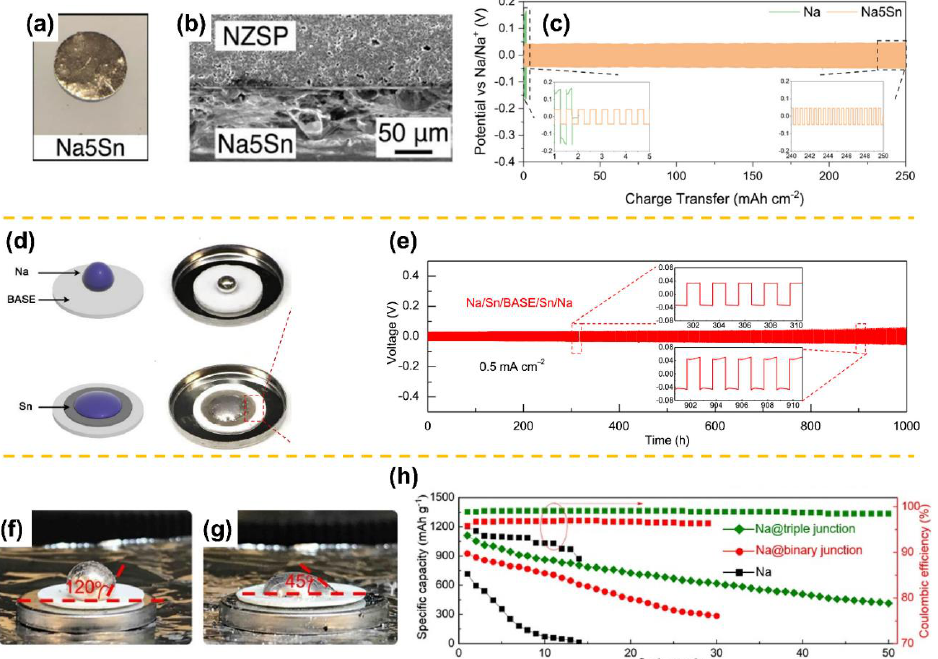
Figure 4. ( a ) The optical images of Na5Sn on NZSP and ( b ) the corresponding cross-section SEM image. ( c ) Cycling stability of Na- and Na5Sn-based symmetric cells at 0.5 mA cm − 2 (adapted with permission from Wiley) . ( d ) Schematic and optical images showing the different wetting behaviors of molten Na on bare and Sn-coated BASE at 150 °C. The sodiophilic phenomenon is observed when Sn serves as an interlayer. ( e ) Galvanostatic voltage profiles of a Na||Sn/BASE/Sn||Na symmetric cell cycled at 0.5 mA cm −2 . Inset: voltage profiles during 301-311 h and 901-911 h (adapted with permission from Elsevier). Contact angles measured for molten ( f ) Na and ( g ) composite ternary Na-C-Na x MoS 2 anodes on BASE. ( h ) Cycling stability of all-solid-state Na-S cells equipped with